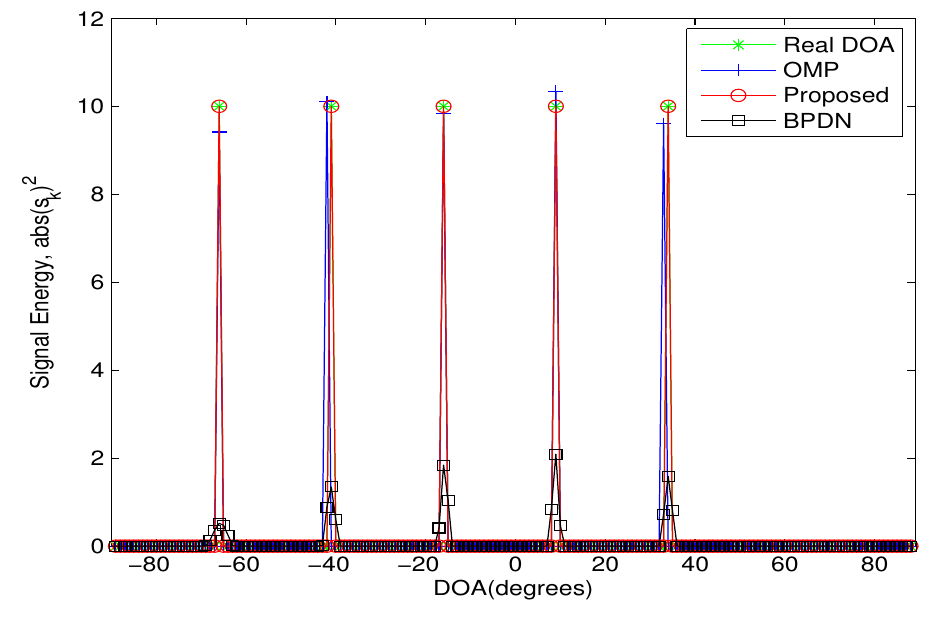
Figure 1. The performance comparison in the ideal case. Five sources are assumed from the Directions of Arrival (DOAs), {− 66 ◦ , − 41 ◦ , − 16 ◦ , 9 ◦ , 34 ◦ } . The power of the sources and noise is 10 dB and zero, respectively. The number of array elements is M = 12 , and the number of snapshots is one.